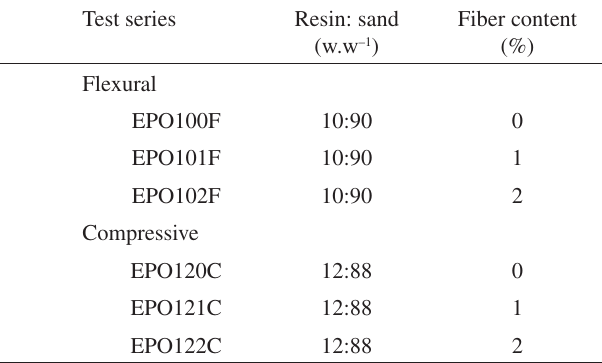
Table 1. Mix proportion of PC formulations.